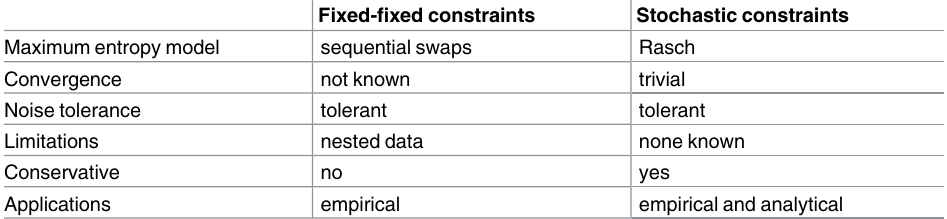
Table 3. Summary of characteristics of fixed-fixed constraints and stochastic constraints